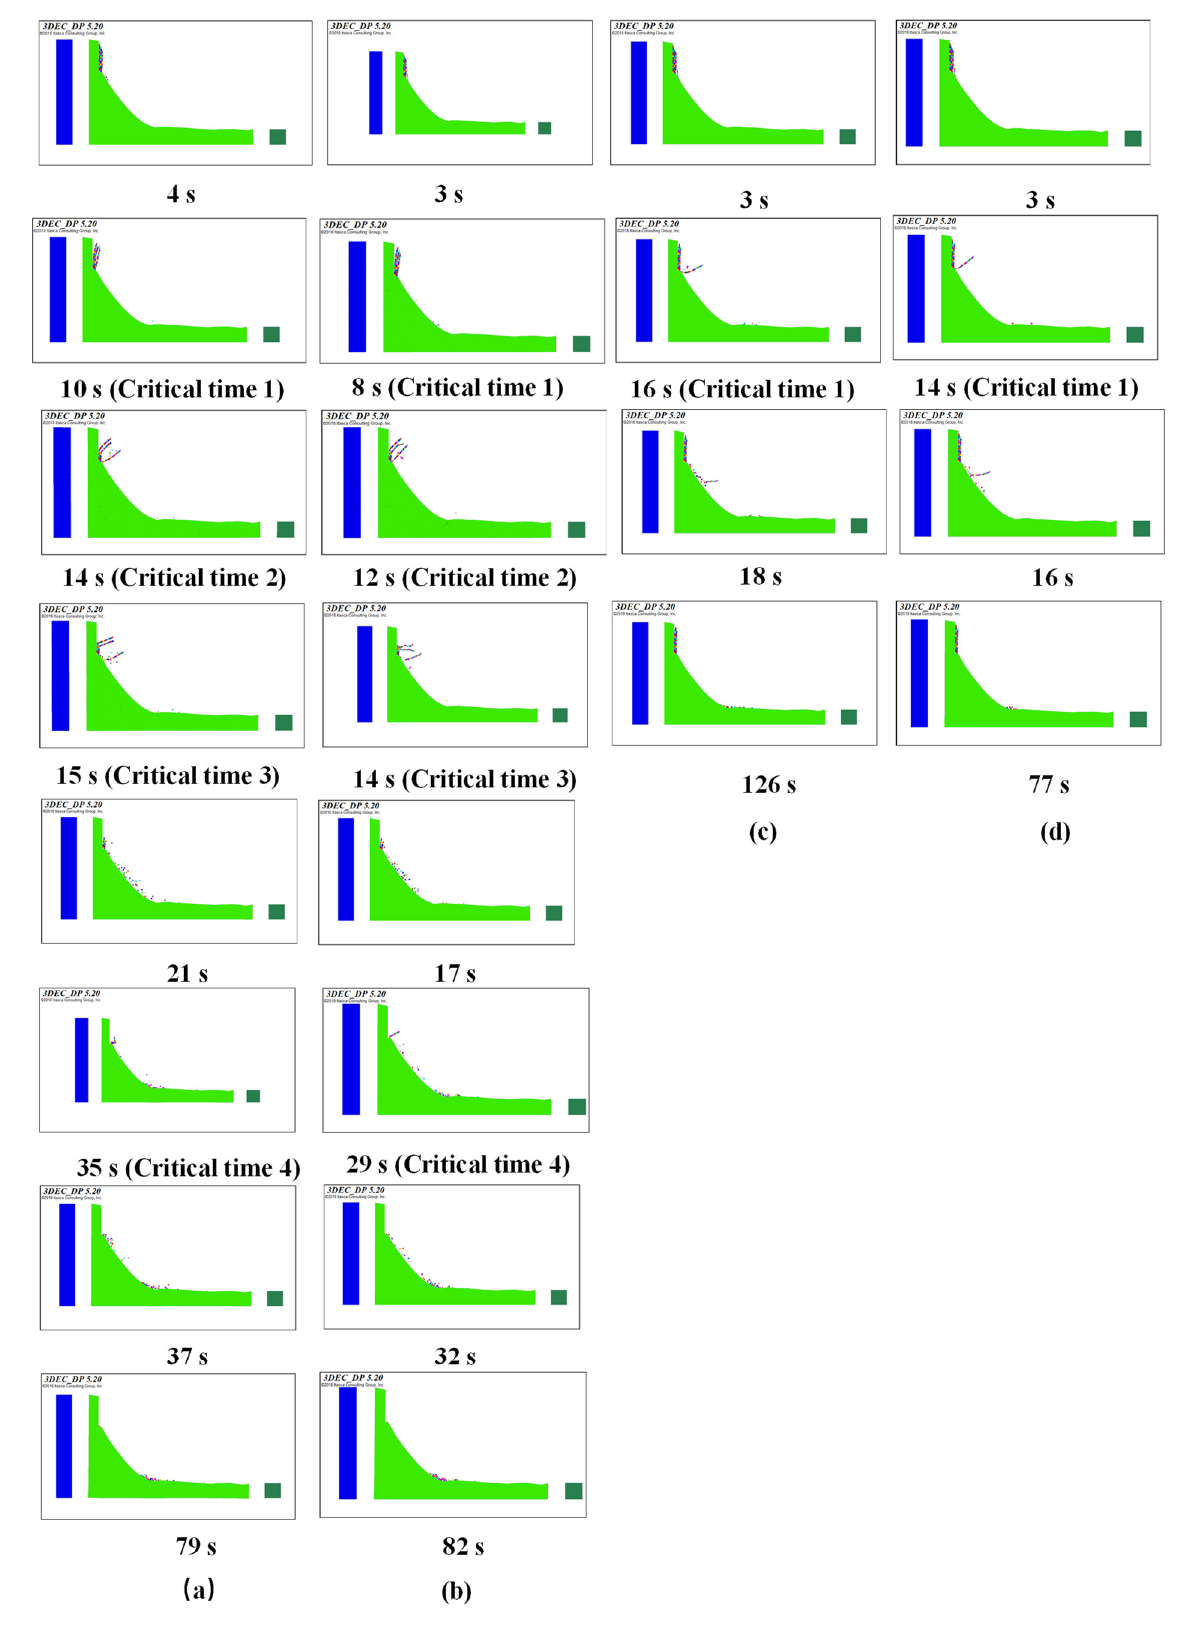
Figure 13. Failure behavior of the high-steep rock slide ( a ) case 1: EW seismic wave; ( b ) case 4: EW_NS_UD seismic wave; ( c ) case 2: NS seismic wave; and ( d ) case 3: UD seismic wave.